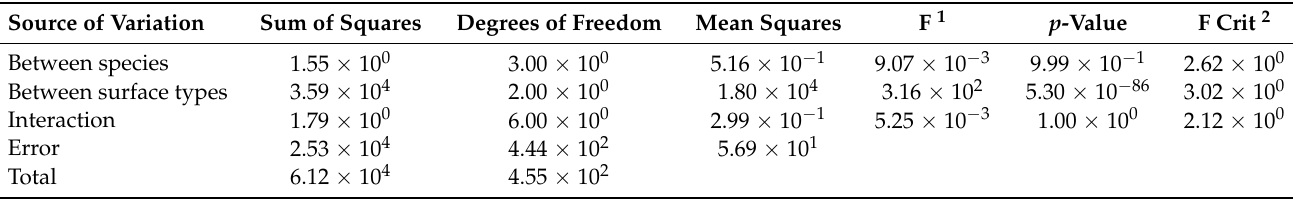
Table 1. Comparison of temperatures between four